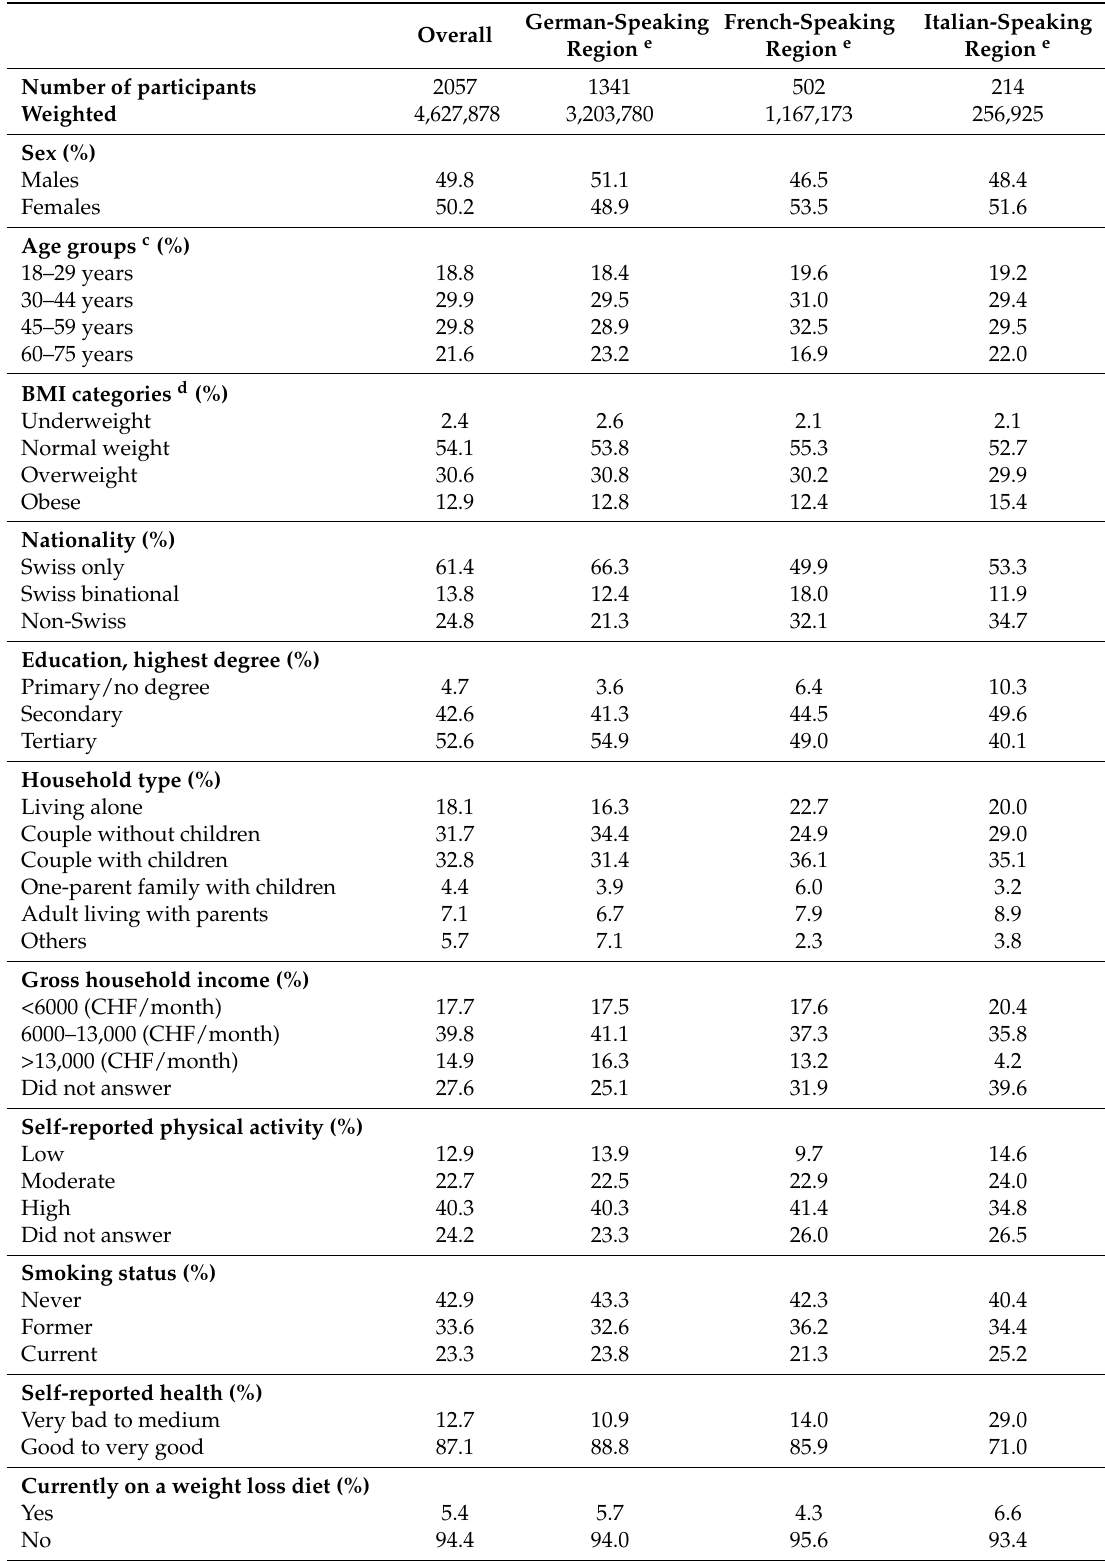
Table 1. Characteristics of the menuCH participants overall and by language regions a,b